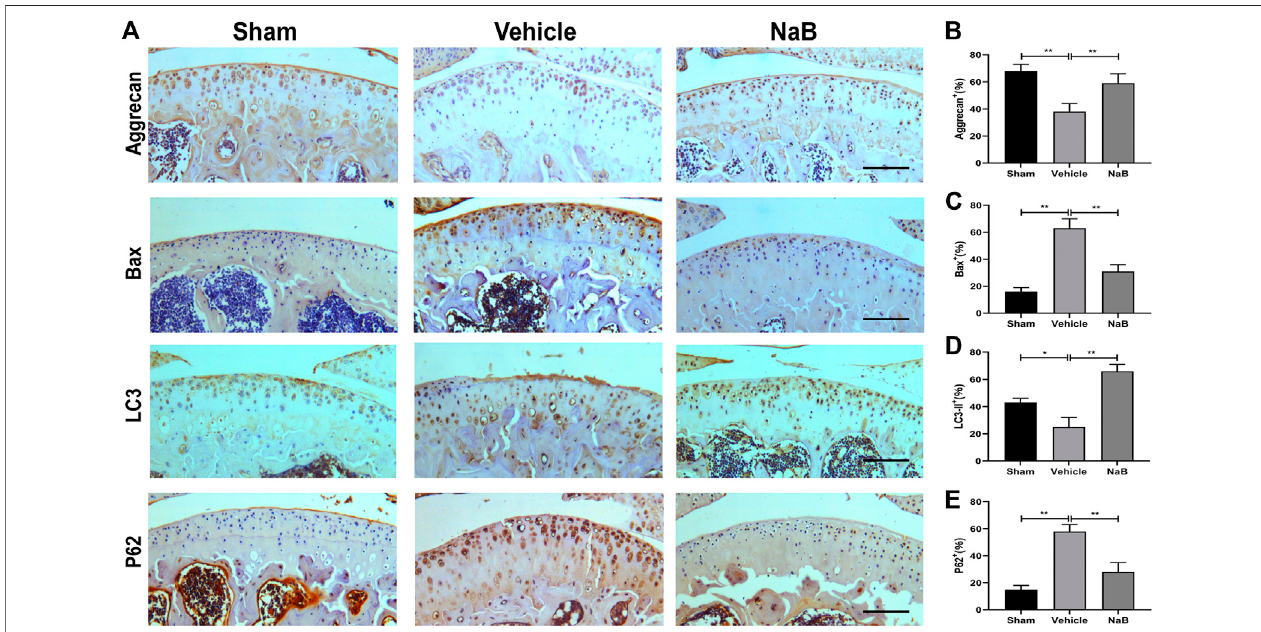
FIGURE 4 | Sodium butyrate (NaB) normalizes the expression of aggrecan, Bax, LC3-II, and p62 in articular cartilage 60 days after the operation. (A) Immunostaining of aggrecan, Bax, LC3-II, and p62 after 60 days postoperation. (B – E) The quanti fi cation of cells with positive staining for aggrecan. (B) , Bax (C) , LC3-II (D) , and p62 (E) ; scale bar,100 μ m, n (cid:2) 10per group. The dataare presented as themean ± S.D.Signi fi cant differences between thedifferentgroups weredetermined by one-way ANOVA; * p < 0.05, ** p <